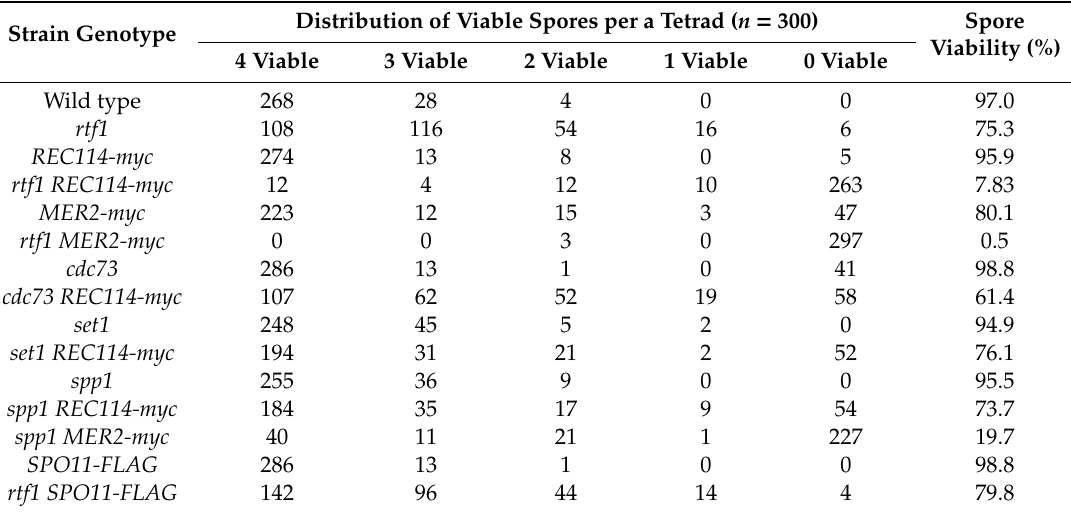
Table 1. Spore viability and distribution of viable